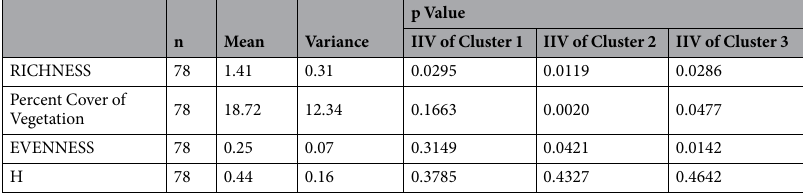
Table 2. Correlation between IIVs of Clusters and vegetation